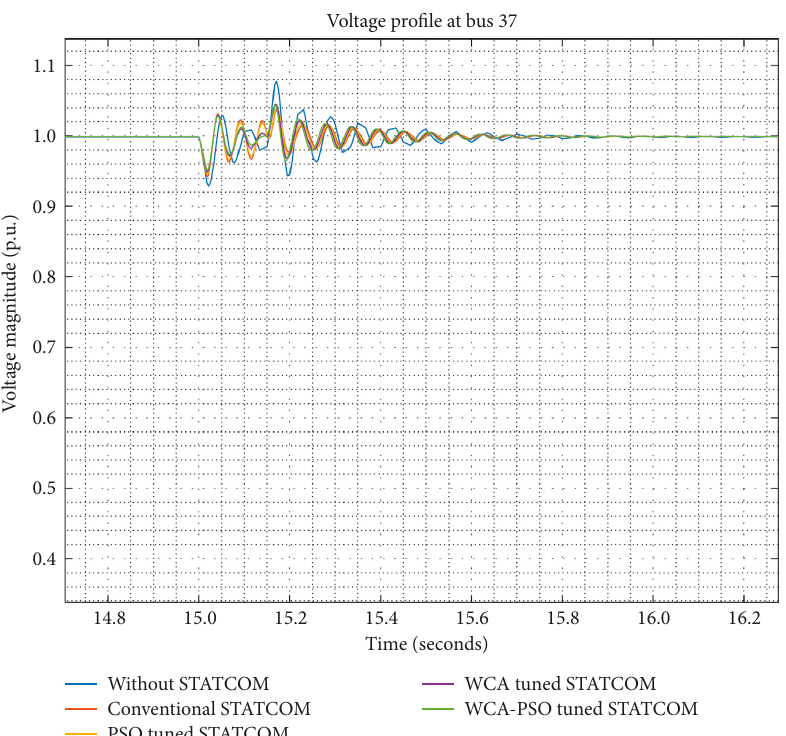
Figure 22: Voltage profile at WPP